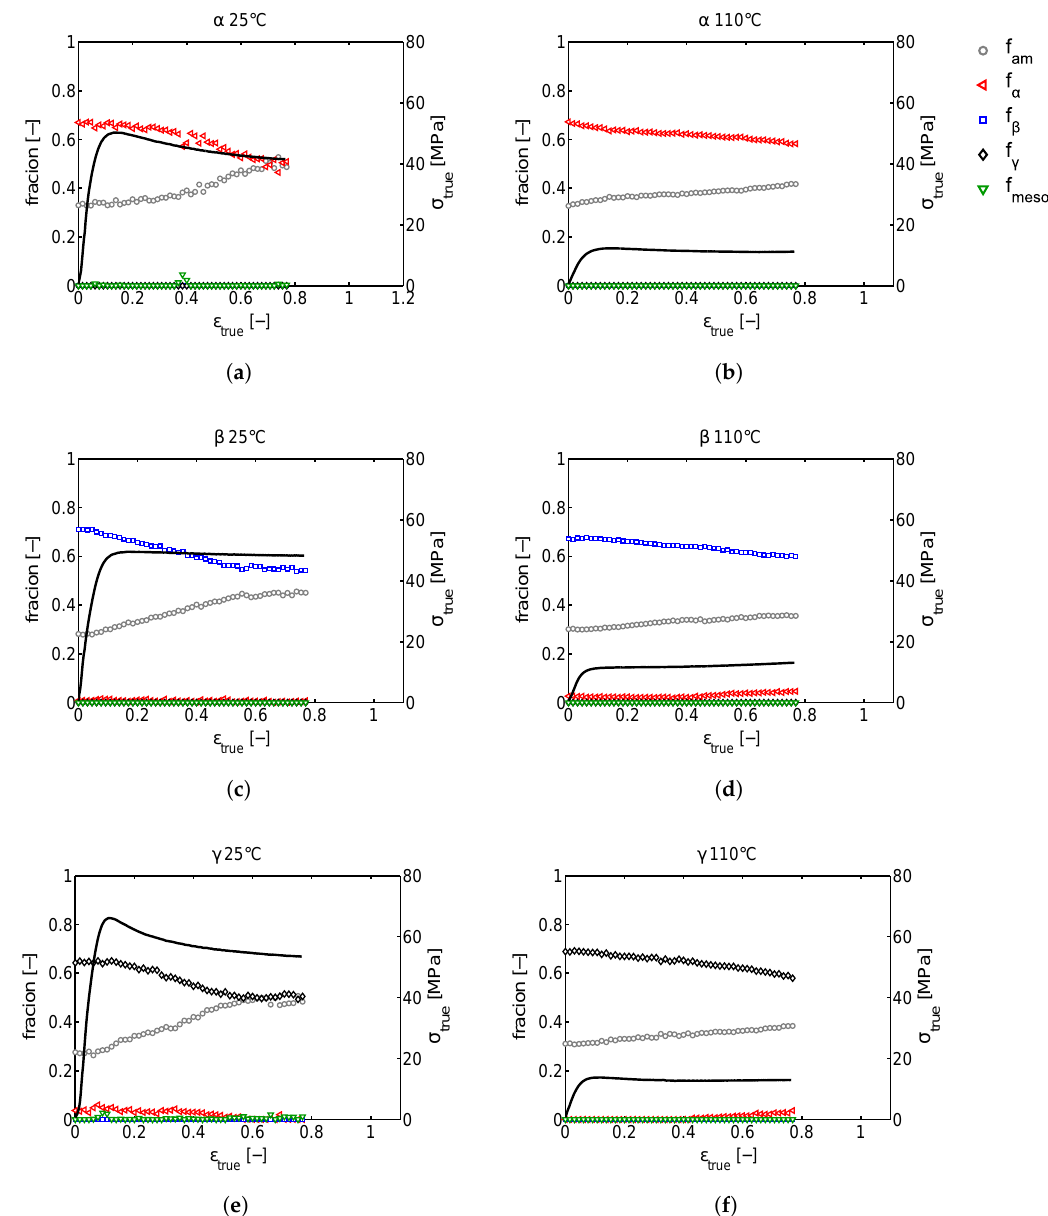
Figure 20. The crystal phase fractions obtained from the WAXD experiments. From top to bottom we see α -, β - and γ -iPP. From left to right we see the evolution of the crystallinity and phase fractions upon compressing at 25 and 110 ◦ C. The true stress as a function of the true strain obtained at a true strain rate of 10 − 2 s − 1 is shown with the solid black